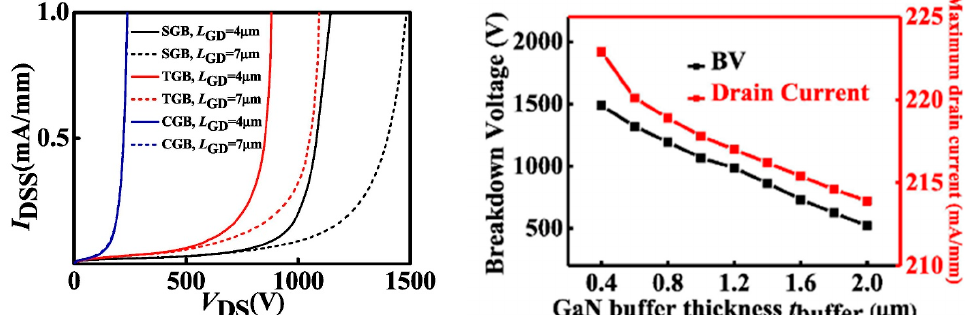
Figure 18. Breakdown voltage (V BR ) of SGB, TGB, and CGB for different gate-to-drain distances (L GD ), and dependence of V BR and peak drain current on GaN buffer thickness. The developed step-etched GaN structure may alter the electric field distribution, resulting in a greater V BR since the equipotential lines are more uniform than for standard HEMTs. Furthermore, at the ideal angle of the GaN buffer, the electron density at the AlGaN/GaN interface is unaffected, resulting in an output I ds –V ds curve and current drive capacity comparable to conventional HEMTs. Reprinted with permission from ref. [219]. Copyright 2021 Elsevier.